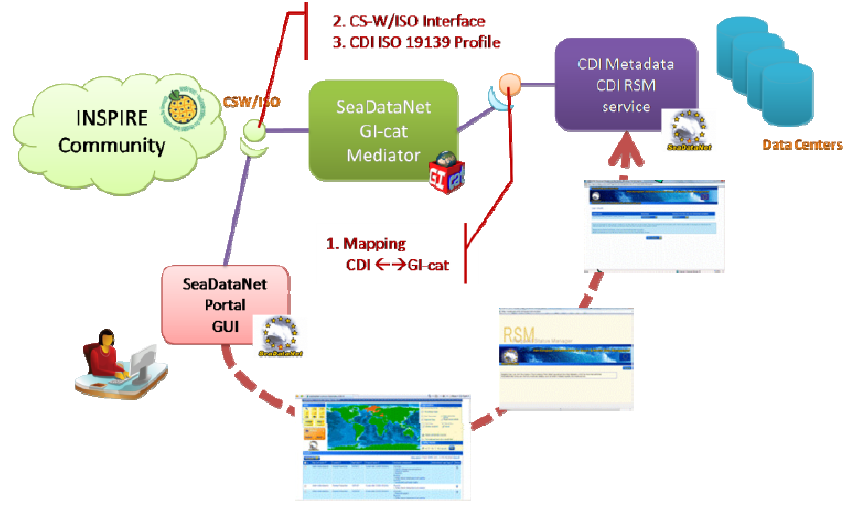
Fig. 3. GI-cat in SeaDataNet